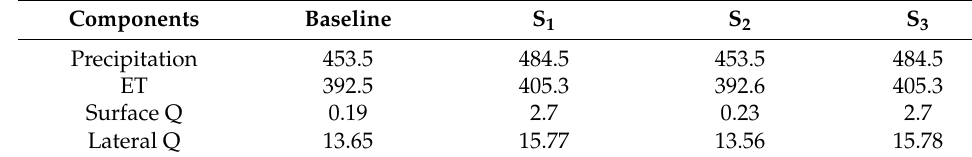
Table 3. Hydrological components in different scenarios (mm).